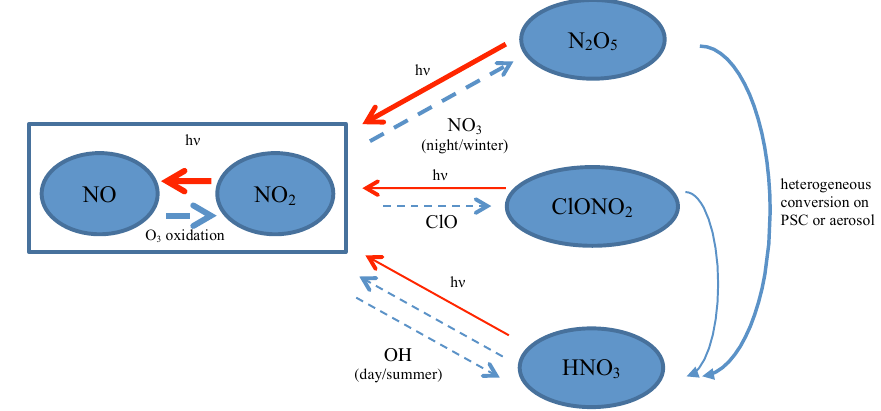
Figure 1. Schematic depiction of relevant interactions between nitrogen species in the stratosphere.